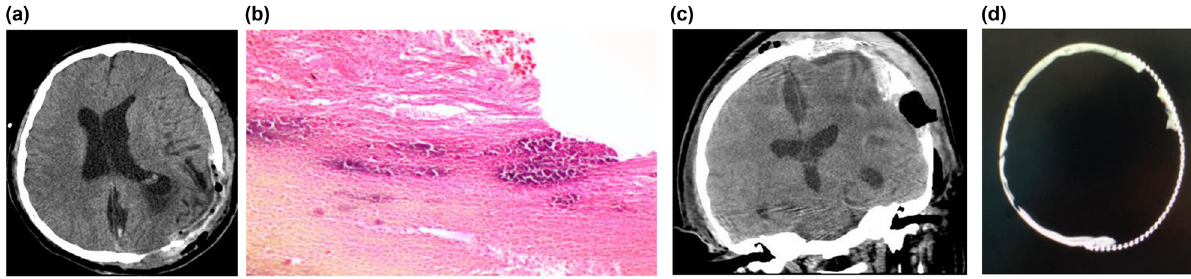
Figure 3: Postoperative examination. ( a ) CT detection on the fi rst day after surgery. The lesion was completely removed, and the brain tissue was restored. ( b ) Postoperative pathology. ( c ) CT detection on the third day after surgery. A small amount of epidural hematoma in the left frontal area occurred, which was conservatively treated. ( d ) CT detection after cranioplasty at 6 months after surgery.